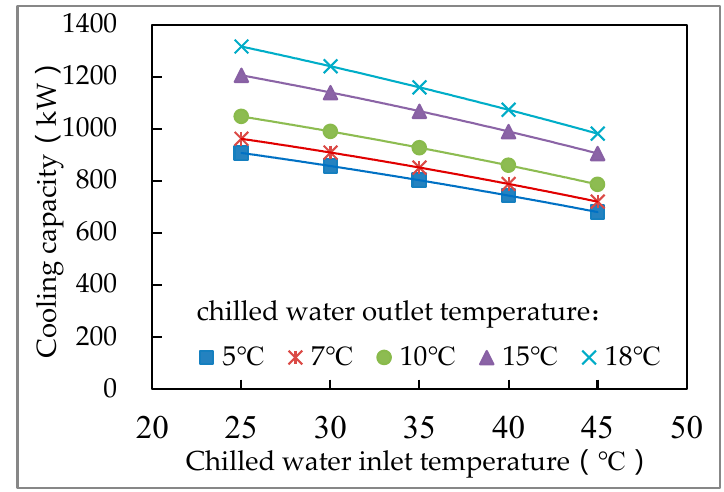
Figure 5. Changes in cooling capacity and chilled water inlet temperature.